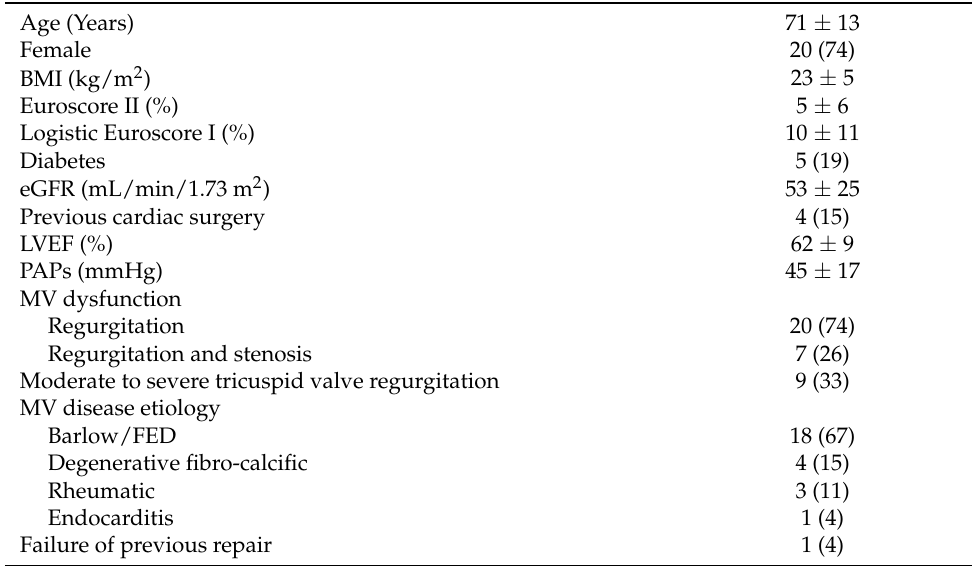
Table 1. Preoperative characteristics (n =